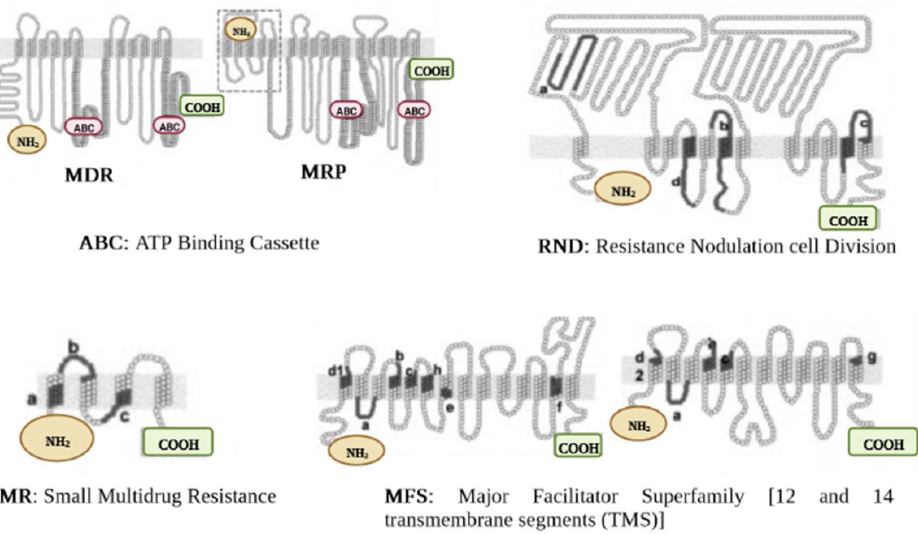
Figure 2. Characteristic topology of major efflux pumps. Proteins are shown as a chain of circles, with solid lines (indicated by letters from a to g) representing conserved motifs in RND, SMR, and